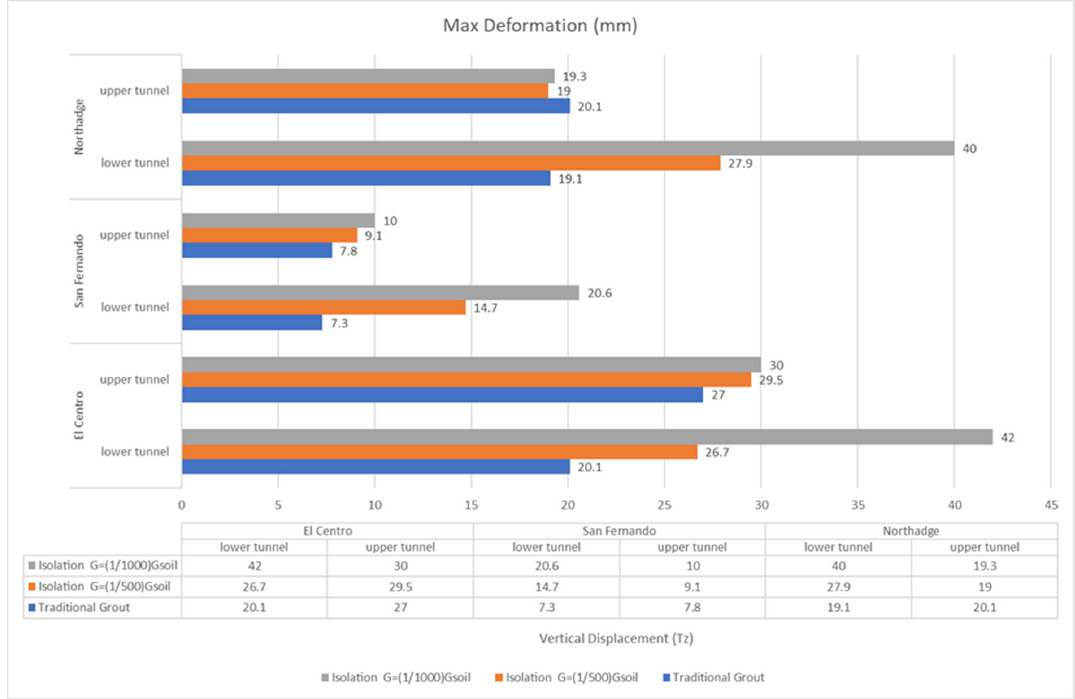
Figure 17. Maximum vertical displacement of the upper tunnel in stiff soil and lower tunnel in soft soil. A comparison of the vertical displacement of twin tunnels under the El Centro and Northridge time histories, which recorded the highest values for deformation in comparison with the San Fernando lodging when using traditional grout and using isolation with a shear modulus ratio of 1 and 1 indicates the 500 1000